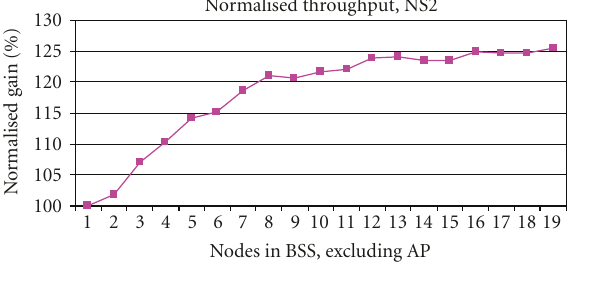
Figure 10: NS-2 normalized gain.